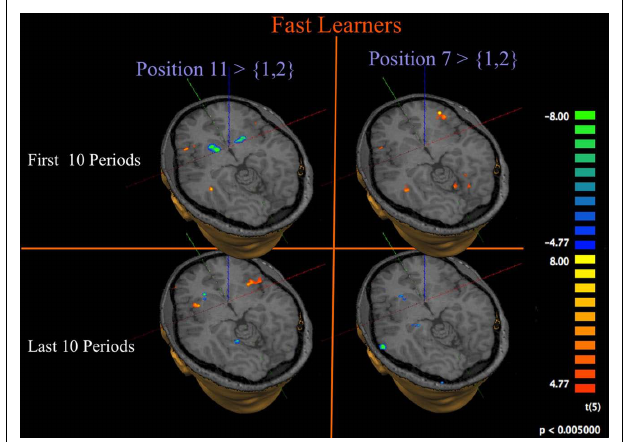
FIGURE 9 | Progression of activation at losing position 11 for fast learners. GLM and contrasts as for Figure 8 , but limited to Fast